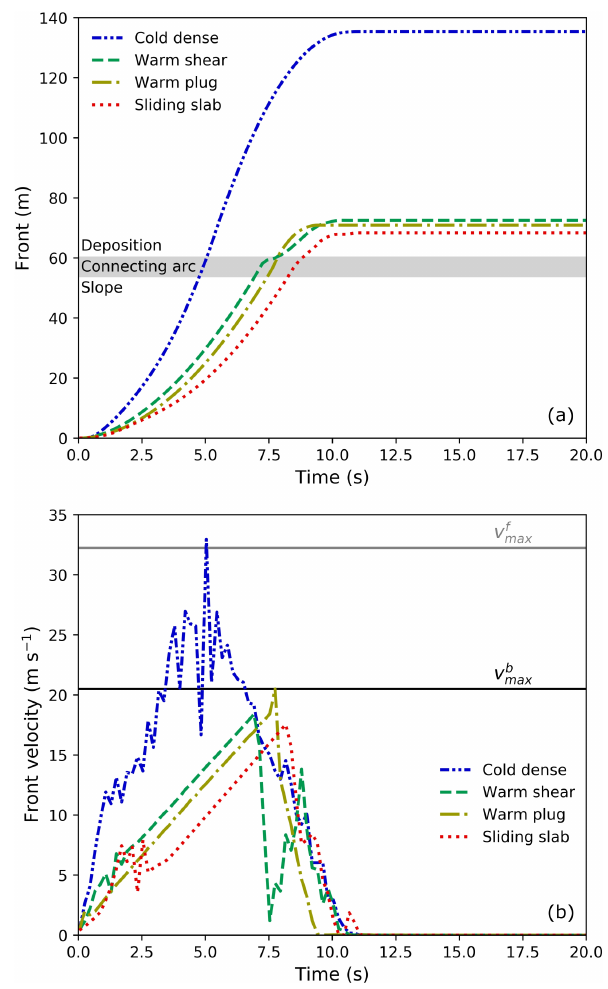
Figure 3. Evolution of (a) front and (b) front velocity of the flows in the four typical regimes (Table 1, Group